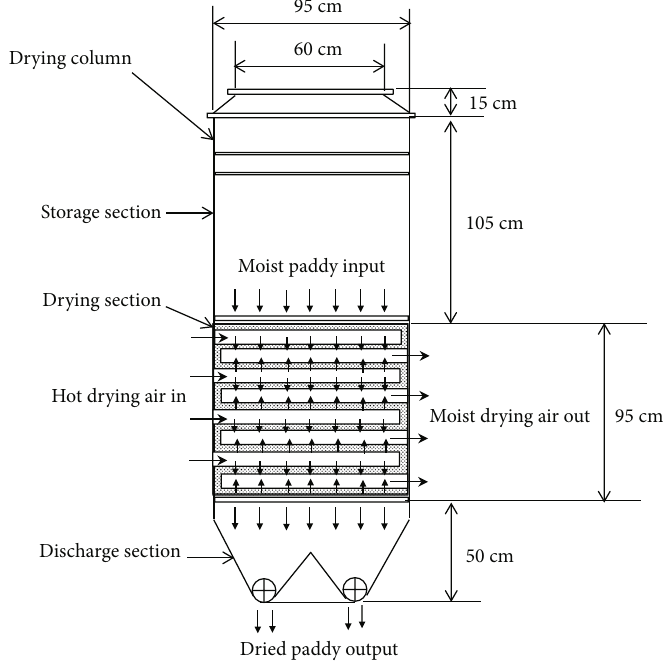
Figure 3: Schematic of the drying column with